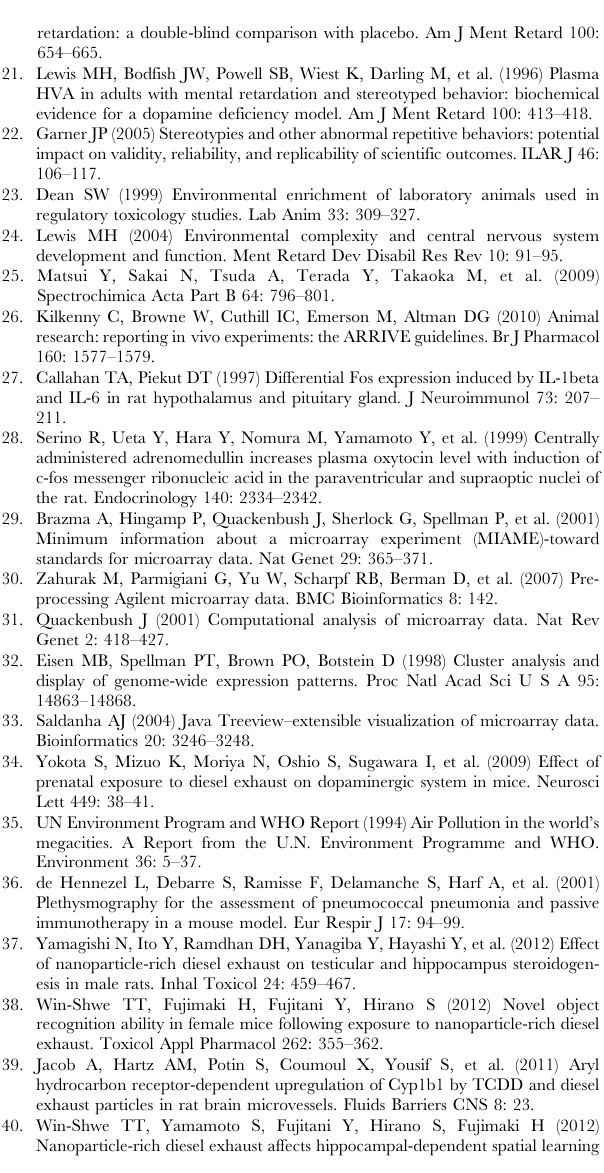
Figure S4 Effect of exposure to diesel exhaust on lung